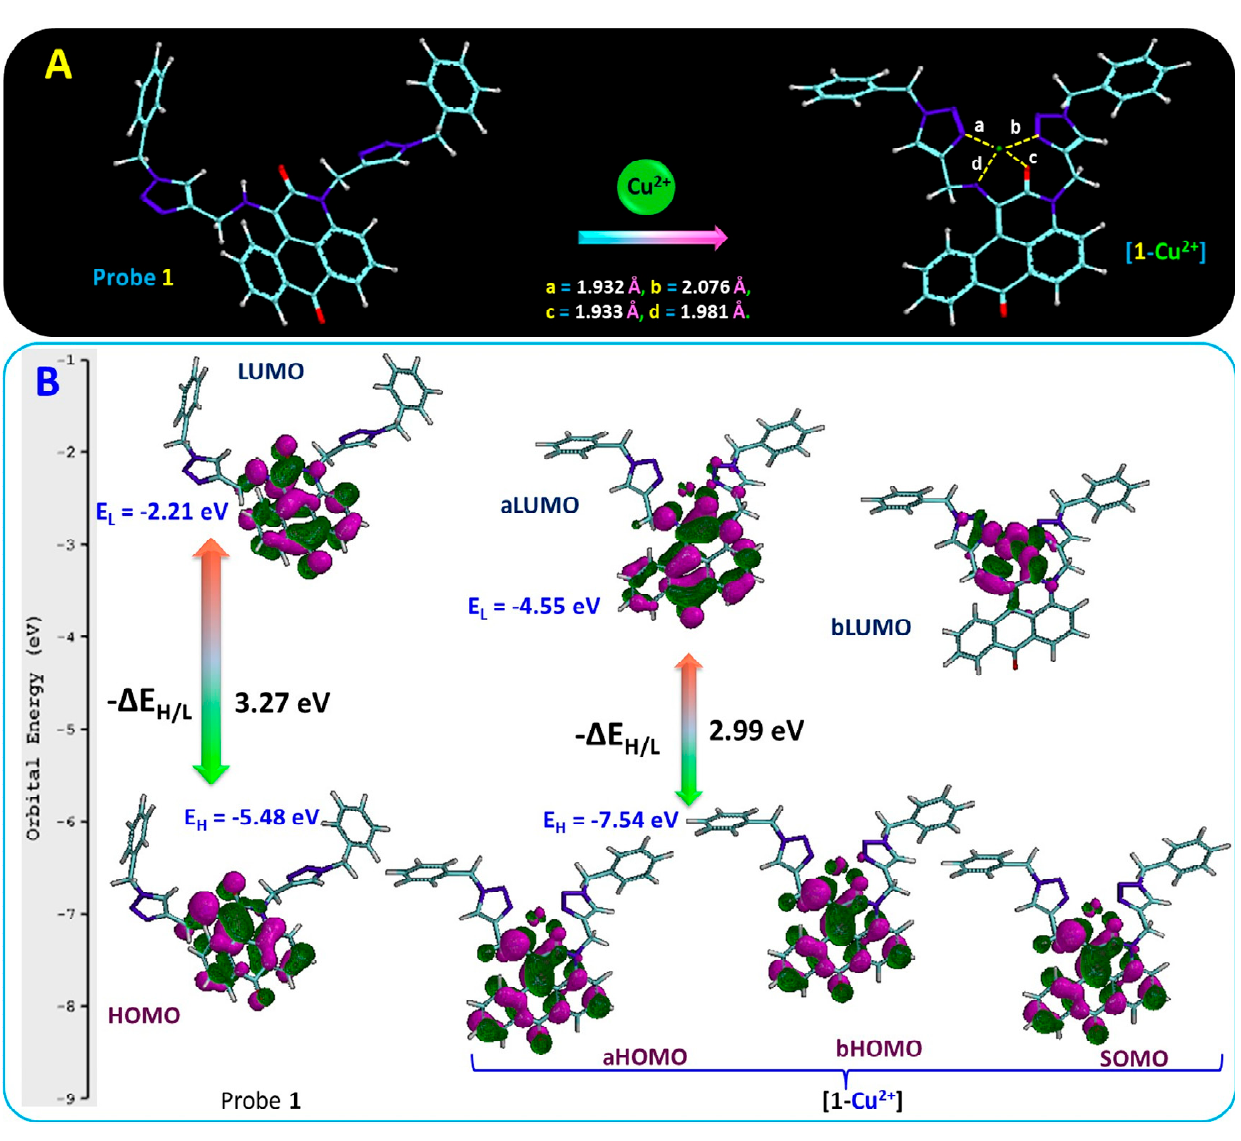
Figure 4. ( A ) Energy-minimized structures of probe 1 and [ 1 -Cu 2+ ]-complex (ball and wire model) and ( B ) electronic distributions and energies of their frontier molecular orbitals (FMOs; HOMOs and LUMOs) obtained from DFT calculations at the B3LYP/6-31G* level. Atoms are color-coded: N = blue, O = red, C = cyan, and H = grey.